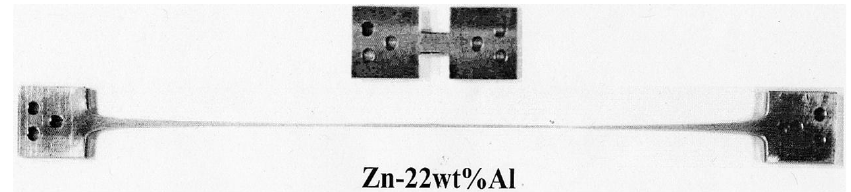
Figure 1. Ductility associated with micrograin